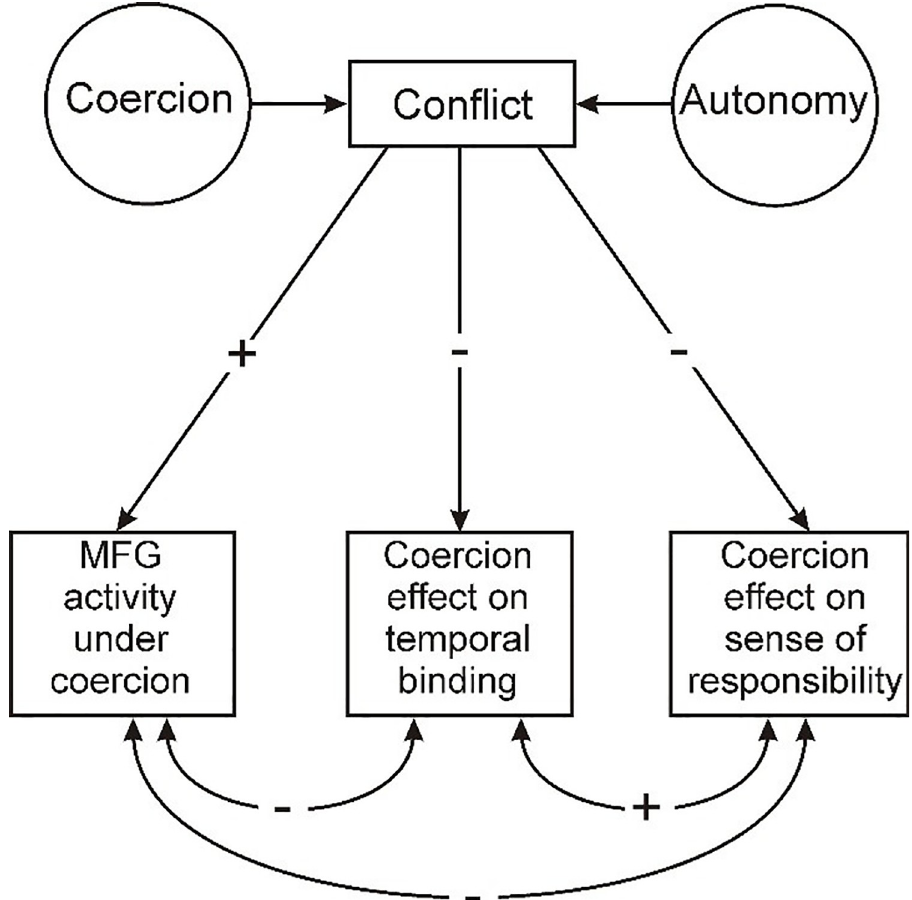
Fig 4. Schematic model showing the proposed underlying cognitive mechanism of the relationship between MFG activity, temporal binding and sense of responsibility under coercion.